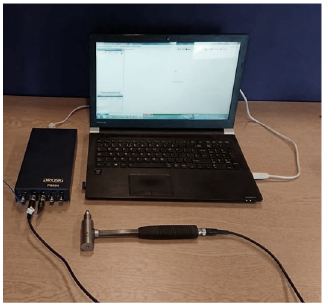
Figure 2. Hammer and Prosig 8004 portable.